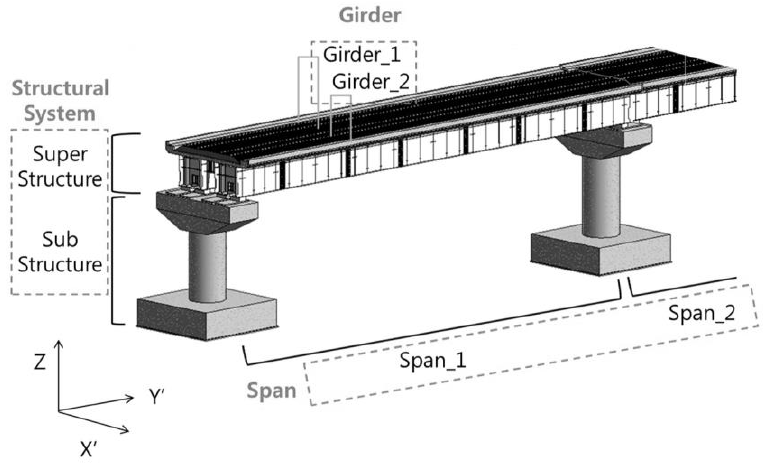
Figure 4. Spatial representation of bridge components.